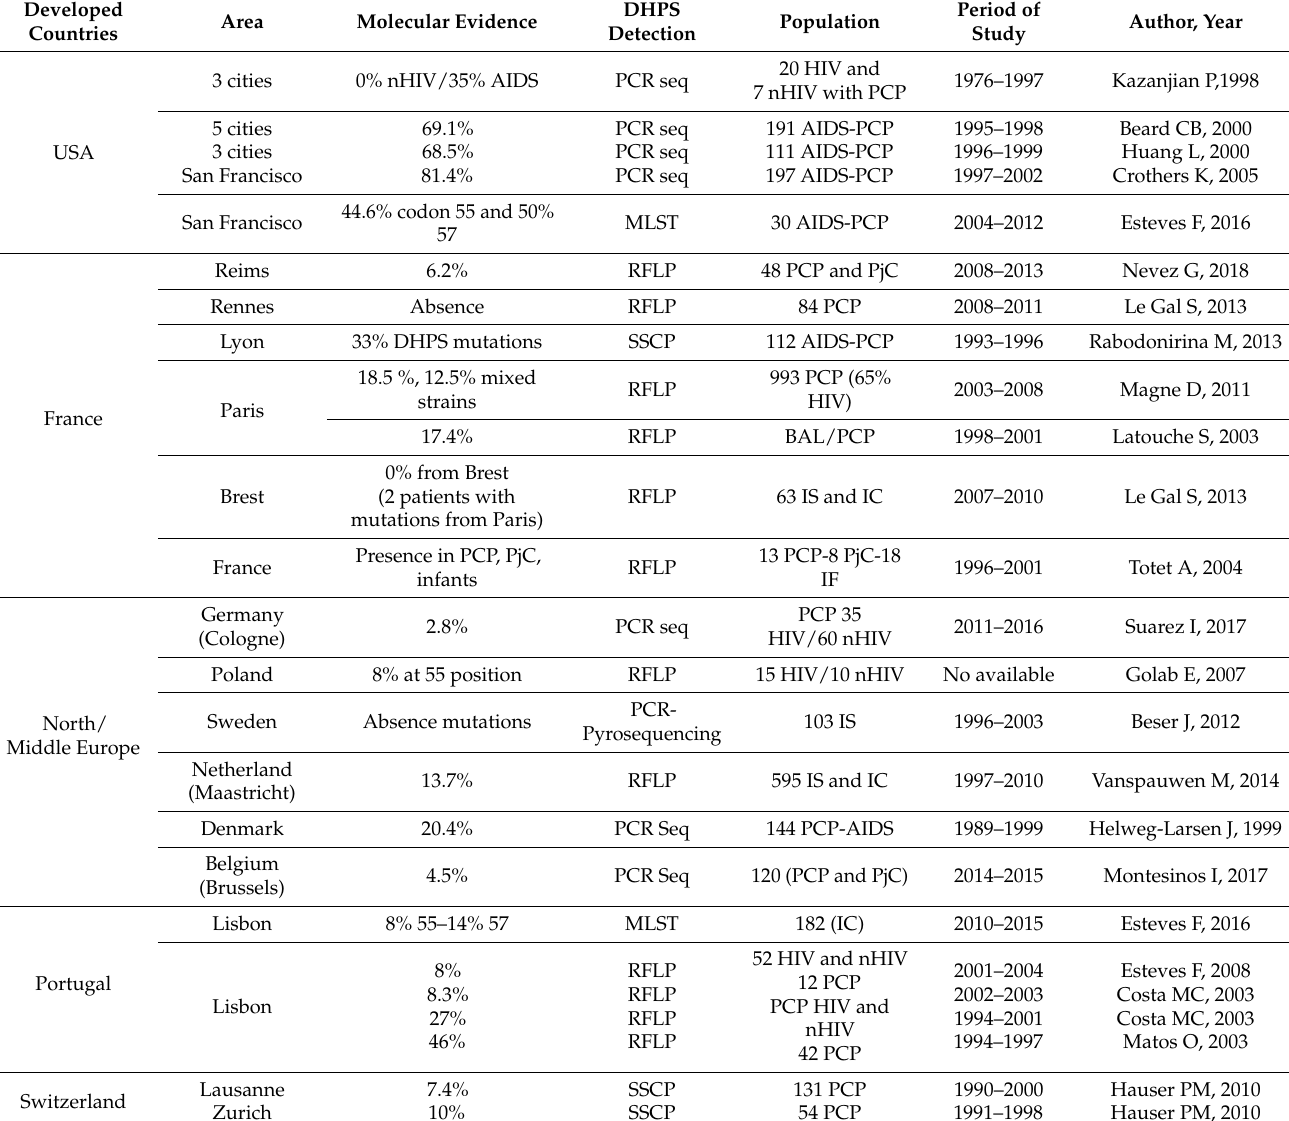
Table 4. Distribution of P. jirovecii with DHPS mutations in developed